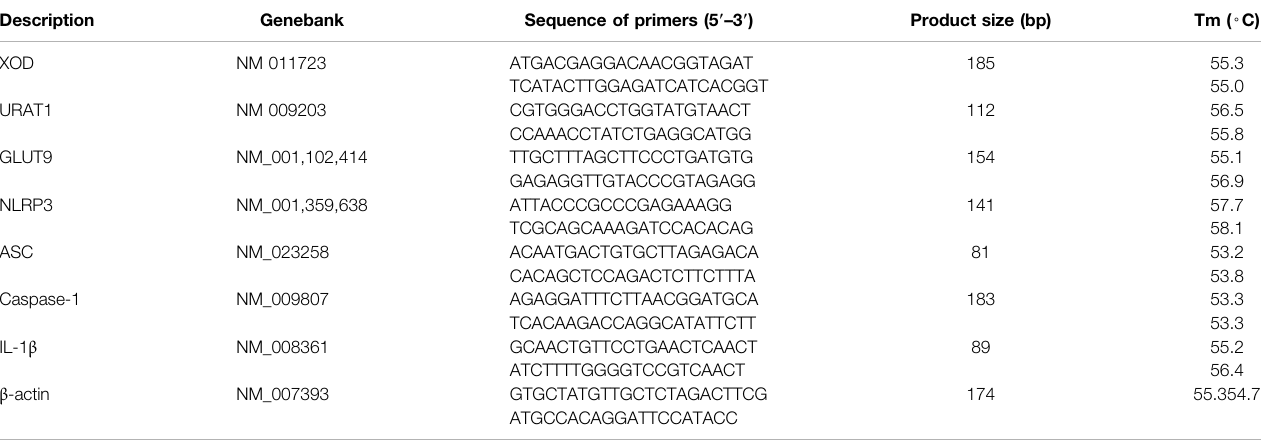
TABLE 1 | Sequences of the primers for real time RT-PCR